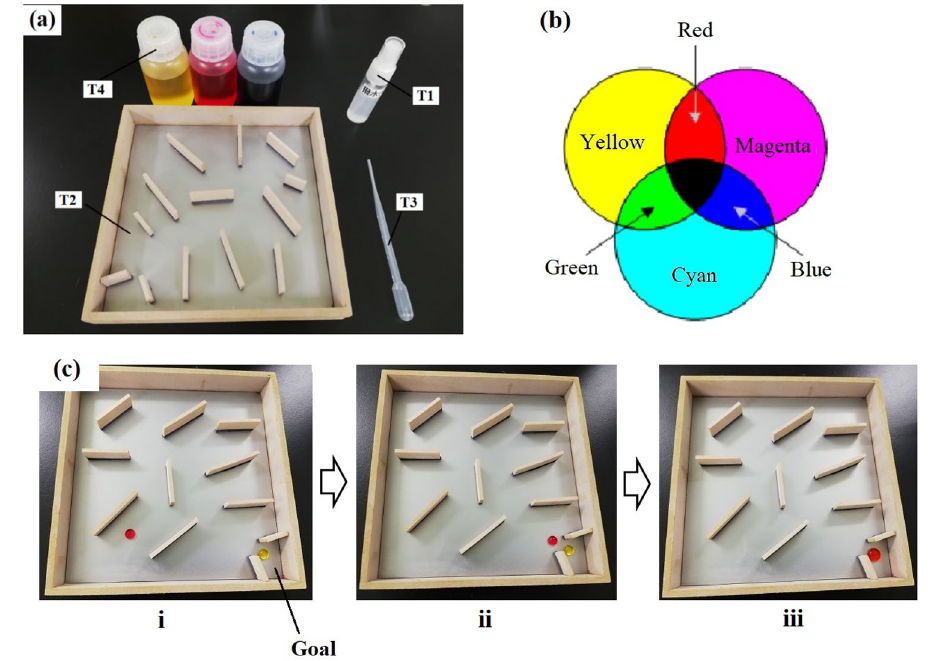
how to play the toy after coating the inner surfaces and all wood blocks: (i) A yellow droplet was dropped at the goal, and the other magenta droplet was dropped at some place outside the goal; (ii) The magenta droplet was moved by shaking the box horizontally or using the tip of the syringe around the blocks to get to the entrance of the goal; (iii) The magenta droplet was moved into the goal to meet the yellow droplet, resulting in the generation of a red